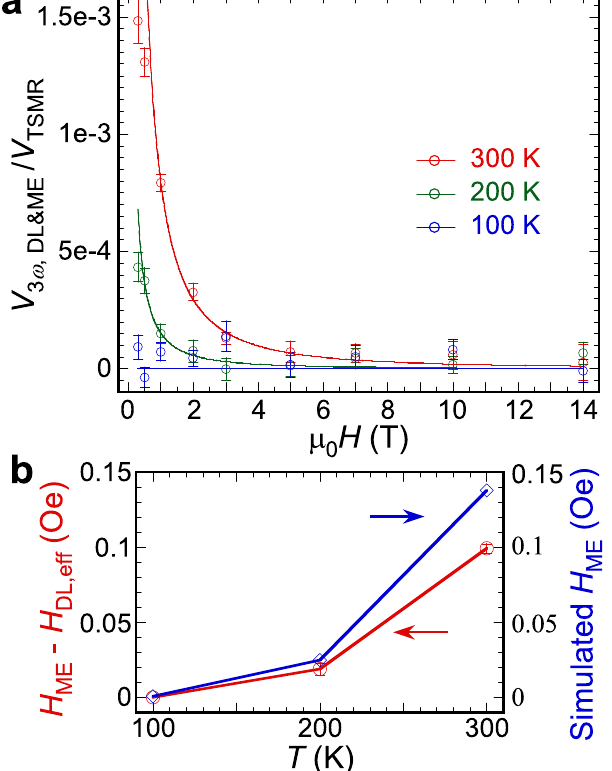
Fig. 4 Third harmonic components. a Damping-like (DL) torque and magnetoelastic effect (ME) contribution V DL þ ME spin Hall magnetoresistance (TSMR) signal V magnetic fi eld at 300, 200, and 100K. Error bars represent fi tting uncertainty. b Temperature dependence of H ME (cid:2) H eff extracted from the fi tting in a by Eq. (3) and simulated H ME (blue) from the magnetic anisotropy energy due to magnetoelastic